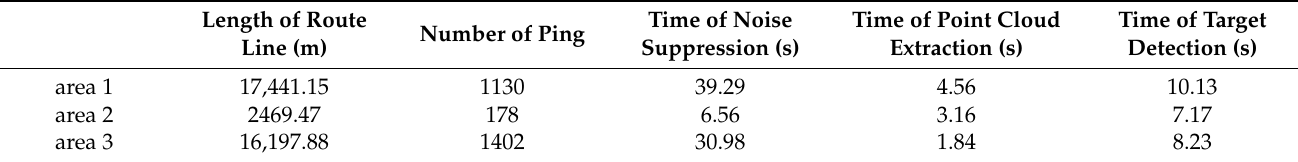
Table 2. The time of the algorithm process.